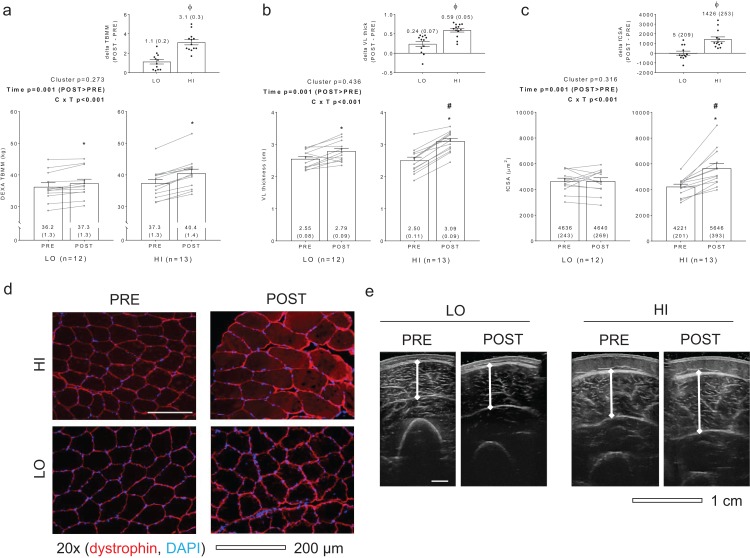
Criterion variables for clustering.PRE and POST values for total body muscle mass (TBMM) assessed via dual x-ray absorptiometry (DEXA) (A), vastus lateralis (VL) thickness assessed via ultrasound (B), and muscle fiber cross sectional area (fCSA) assessed via histology (C) between LO and HI response clusters. Notably, all three variables were used to develop HI and LO response clusters as outlined in the methods. All bar graph data are presented as means ± parenthesized standard error values, and bars are overlaid on individual responses. Additionally, POST—PRE values are presented as insets on (A–C). (D) contains representative fCSA and panel e contains representative VL thickness images of HI and LO responders. Study sites: *, POST > PRE within a given cluster (p < 0.05); #, HI POST > LO POST (p < 0.05); ϕ, delta (POST—PRE) value is greater in HI versus LO (p < 0.001).